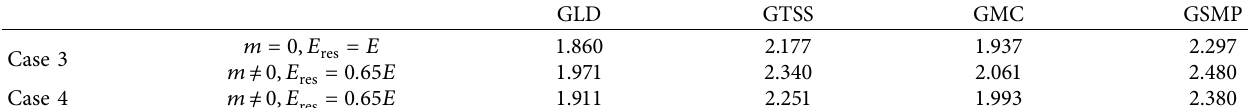
E / ( p R )) of the circular tunnel. 0 0 0